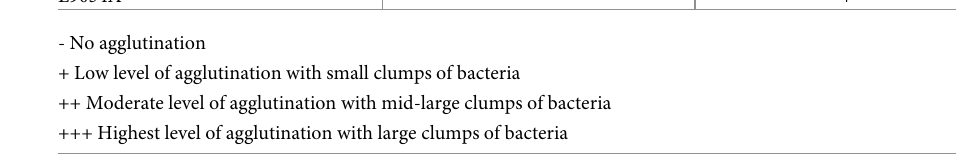
+ Low level of agglutination with small clumps of bacteria ++ Moderate level of agglutination with mid-large clumps of bacteria +++ Highest level of agglutination with large clumps of bacteria